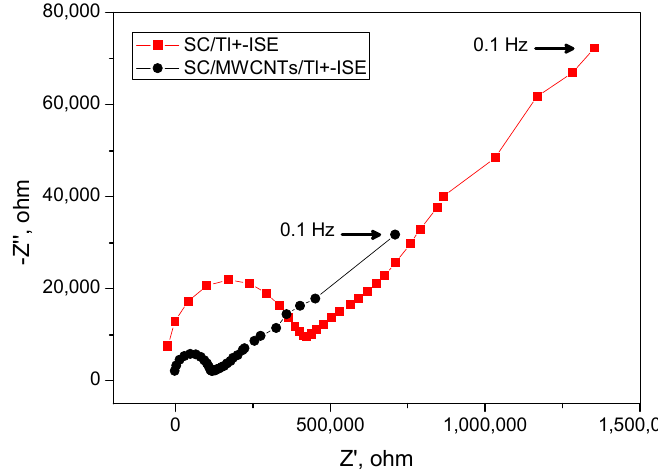
Figure 7. Electrochemical impedance spectroscopy (EIS)spectra of the SC / MWCNTs / Tl + -ISE with (circles) and SC / Tl + -ISE (squares) without the solid-contact layer of MWCNTs measured in 1.5 × 10 − 5 Tl (I) solution.